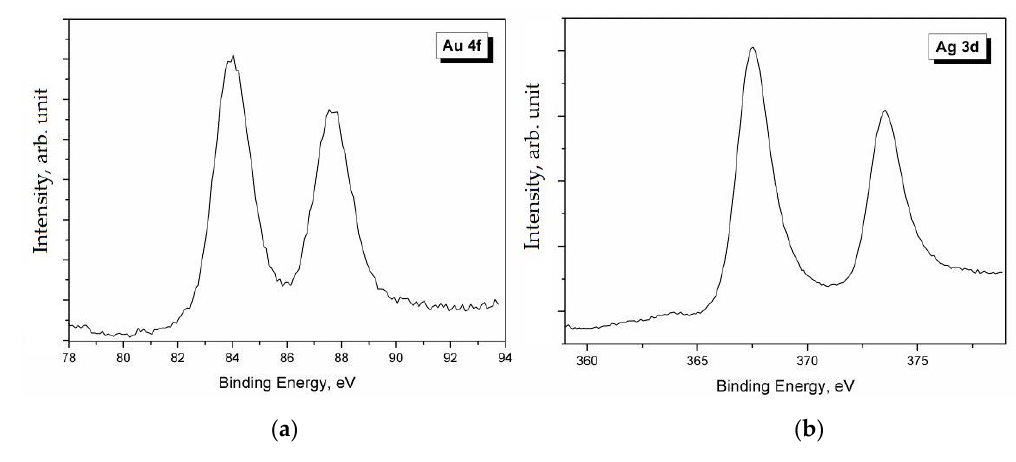
Figure 3. High-resolution XPS spectra of Au 4f ( a ) and Ag 3d ( b ).